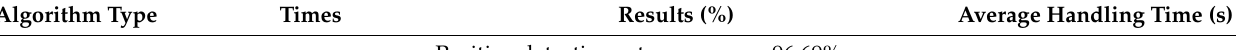
Figure 9. Algorithm detection results: ( a ) two cluster centers on a fruit tree; ( b ) results processed using this algorithm. Table 4. Two-dimensional LiDAR sensor parameters.